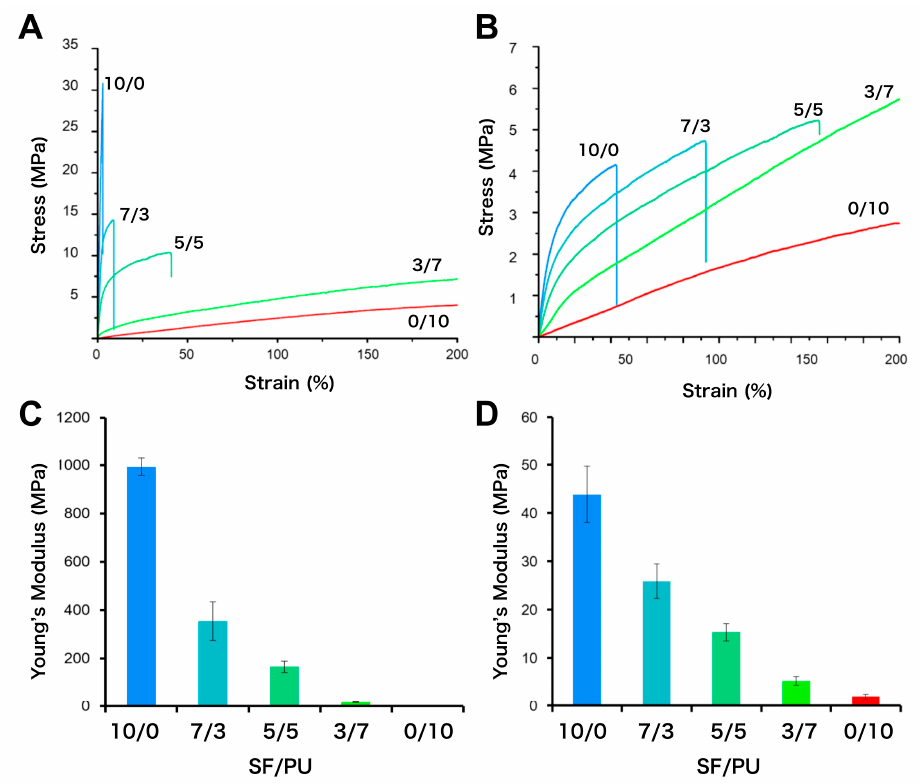
Figure 5. Stress-strain curve of SF/PU composite non-woven sheets in dry ( A ) and wet ( B ) states; and the Young’s modulus calculated from stress-strain curves in dry ( C ) and wet ( D ) state. The Young’s modulus of SF/PU = 0/10 in the dry state ( C ) could not be shown in the bar because of the very low value (2.9 ± 0.1 MPa) compared to the others.